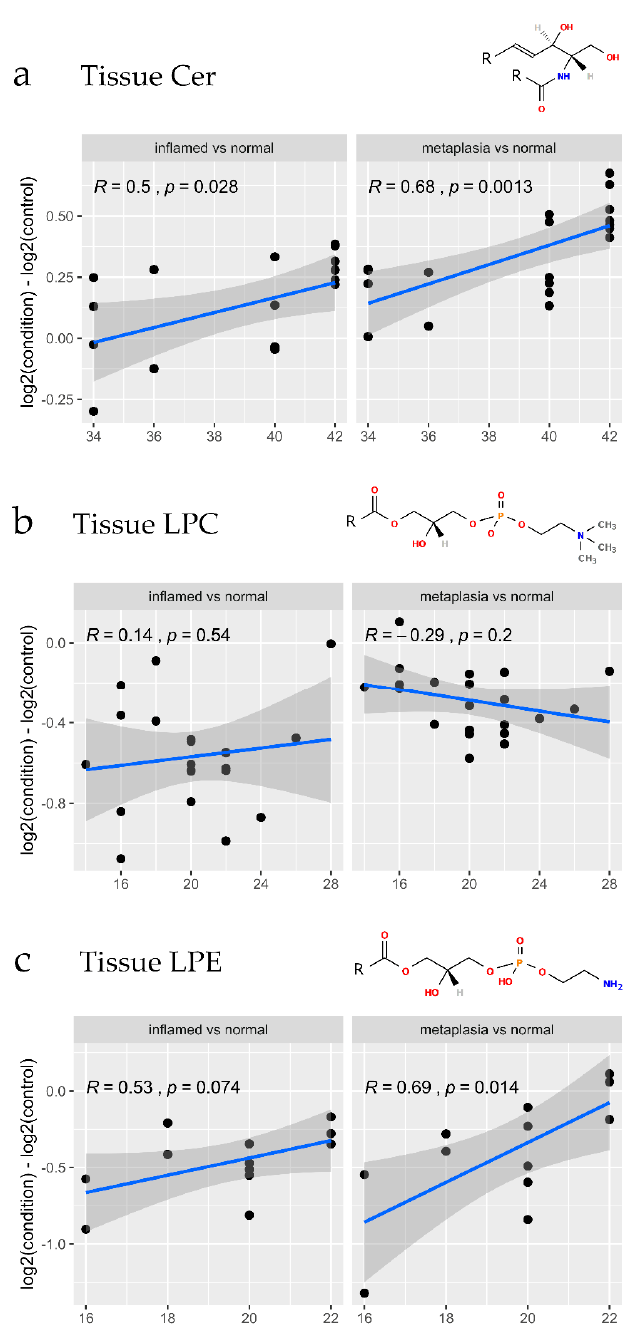
Figure 6. Association of tissue ceramide, LPC and LPE fatty acid chain lengths with gastroesophageal junction tissue pathology. ( a – c ) Total chain length plots for tissue lipids, showing the alterations in log2 abundances between the disease condition and control. The x-axis labels refer to the total fatty acid chain length of the measured lipid. The disease conditions metaplasia and inflammation were visualized after applying the removeBatchE ff ect function from the limma R package. Positive values represent lipids that are more abundant in the disease condition group than in the control group. The metrics shown in the plots refer to the Pearson correlation coe ffi cient (R) and p -value. The smoothed line and 95% confidence interval were drawn using geom_smooth, by fitting a linear model. The structures above each plot represent lipid species of the Ceramide, LPC and LPE classes, where the R groups refer to the hydrocarbon chains of varying